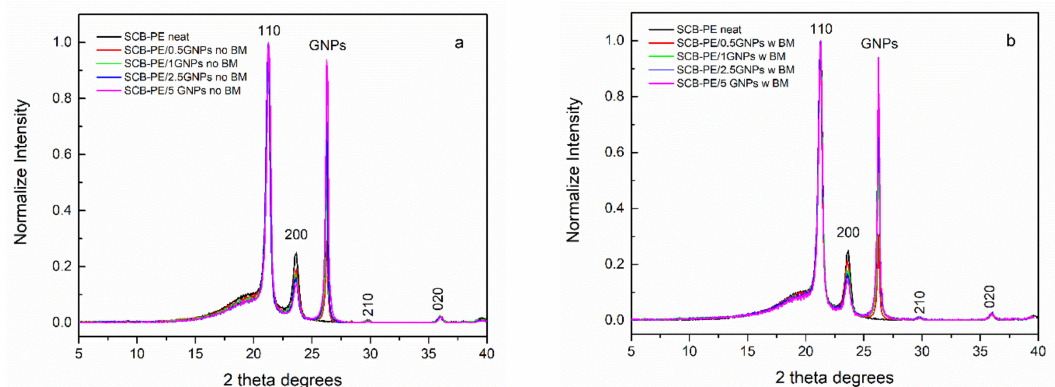
Figure 1. XRD patterns of ( a ) neat SCB-PE and SCB-PE/GNPs no BM, ( b ) neat SCB-PE and SCB-PE/GNPs no